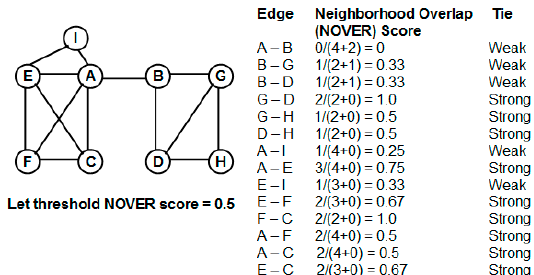
Figure 1. Example to illustrate the calculation of the neighborhood overlap score and identification of weak ties.